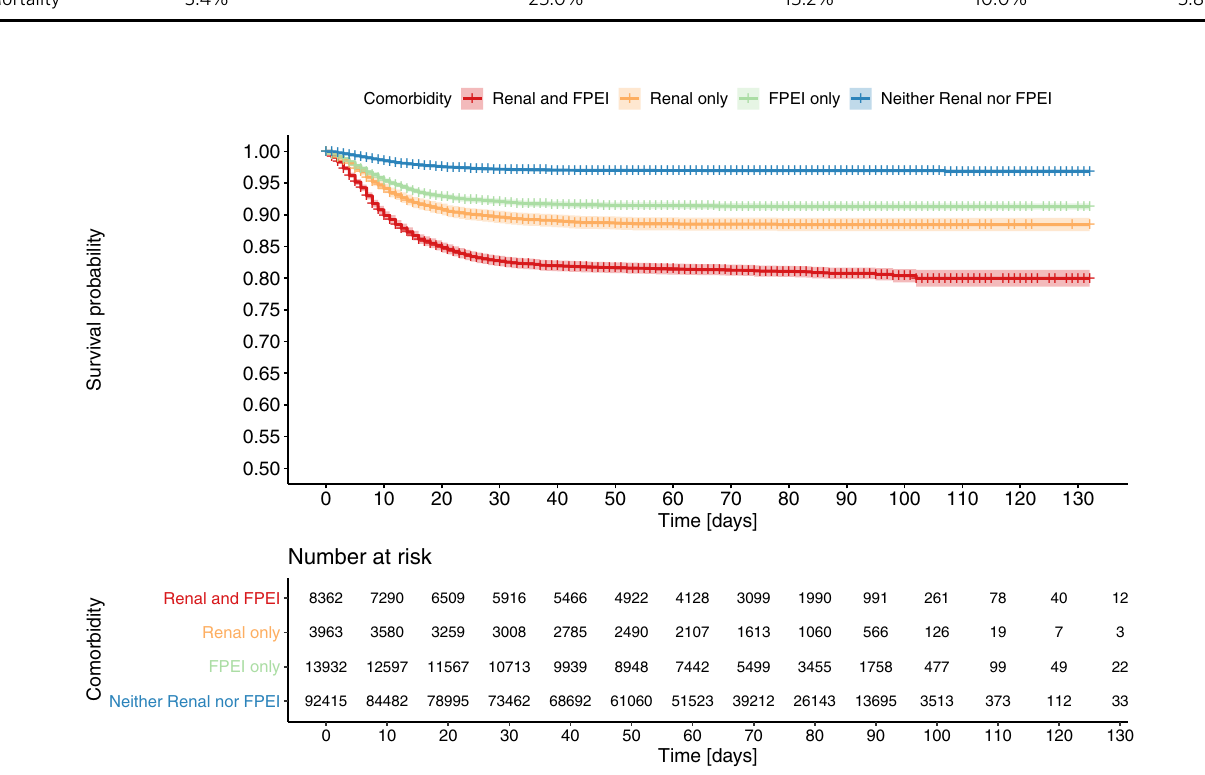
Fig. 2 Overall survival of patients with a priori comorbidities associated with renal disorders and/or fl uid, pH, and electrolyte imbalance (FPEI) as a Kaplan – Meier plot. Descriptors show overall survival of patients with either renal (orange) or FPEI (green) comorbidities, as well as patients with both (red) or neither (blue) comorbidities. For the N = number of patients at risk, see the table insert in the fi